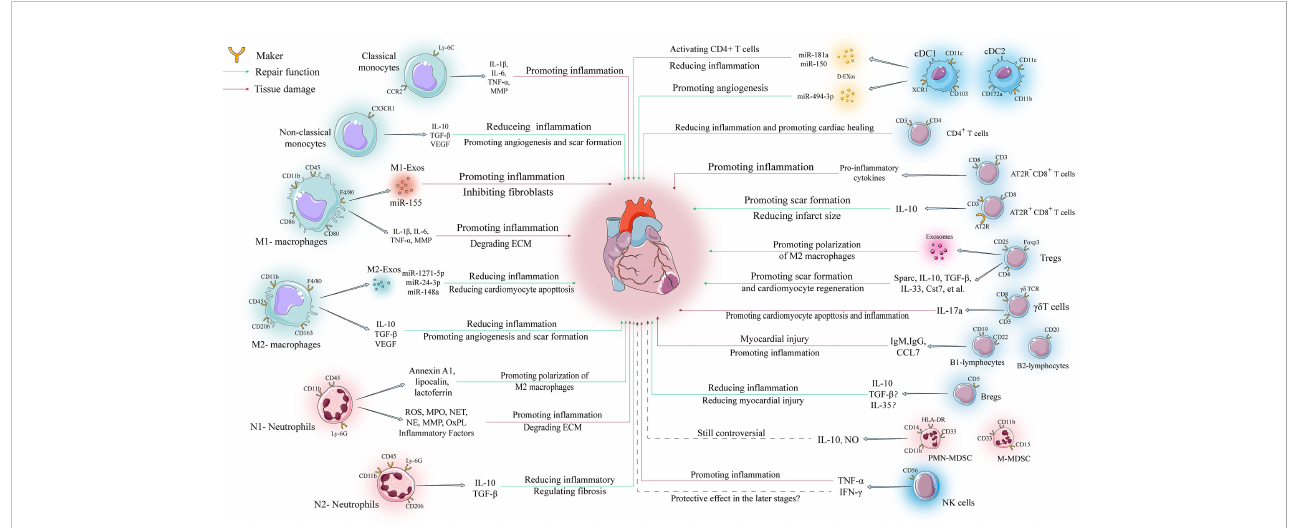
FIGURE 2 Regulatory mechanisms of various immune cells in ventricular remodeling. The involvement of immune cells in ventricular remodeling is often bidirectional, with various immune cells secreting different cytokines to perform different functions depending on their phenotype during different stages of ventricular